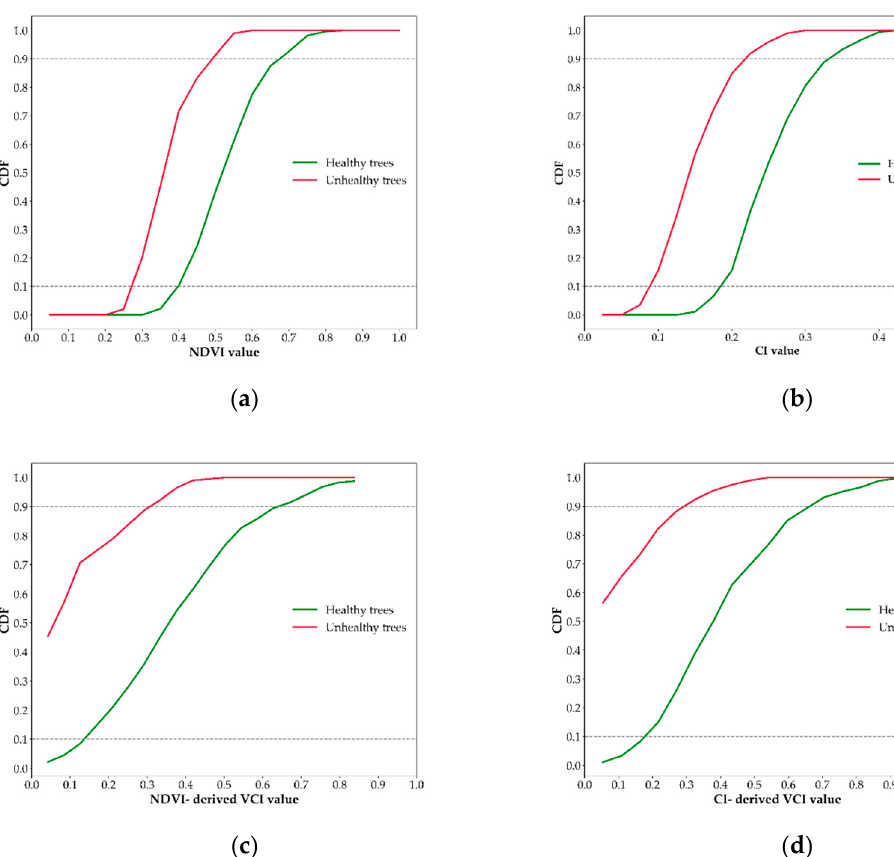
Figure 9. Cumulative distribution function (CDF) applied to NDVI ( a ), CI ( b ), NDVI-derived VCI ( d ), and CI-derived VCI ( d ) for site HMG. Green lines show the cumulative probability of healthy trees while red lines show the cumulative probability of unhealthy trees.